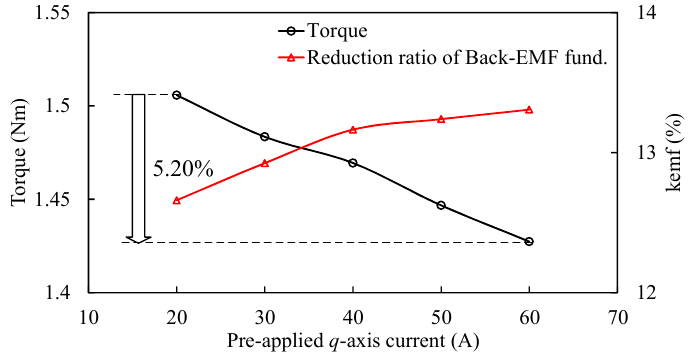
Figure 6. Variations of average torques with the pre-applied q -axis current.